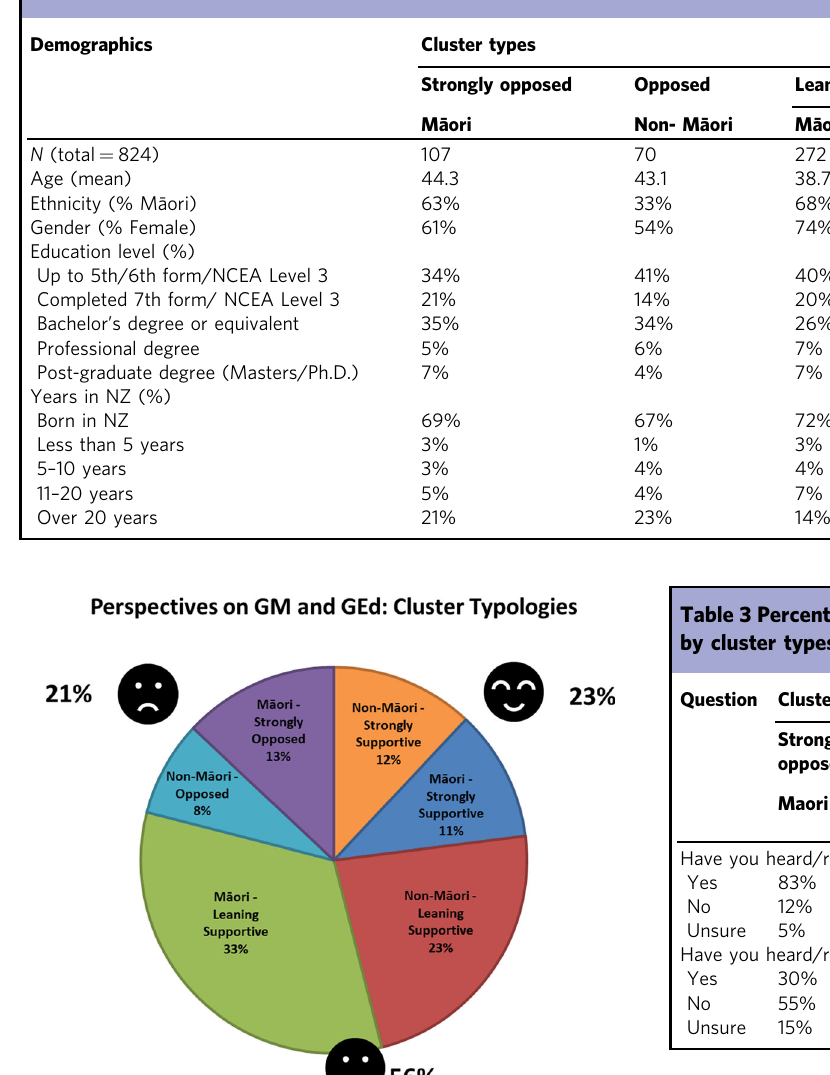
Table 2 Key demographics by cluster types.